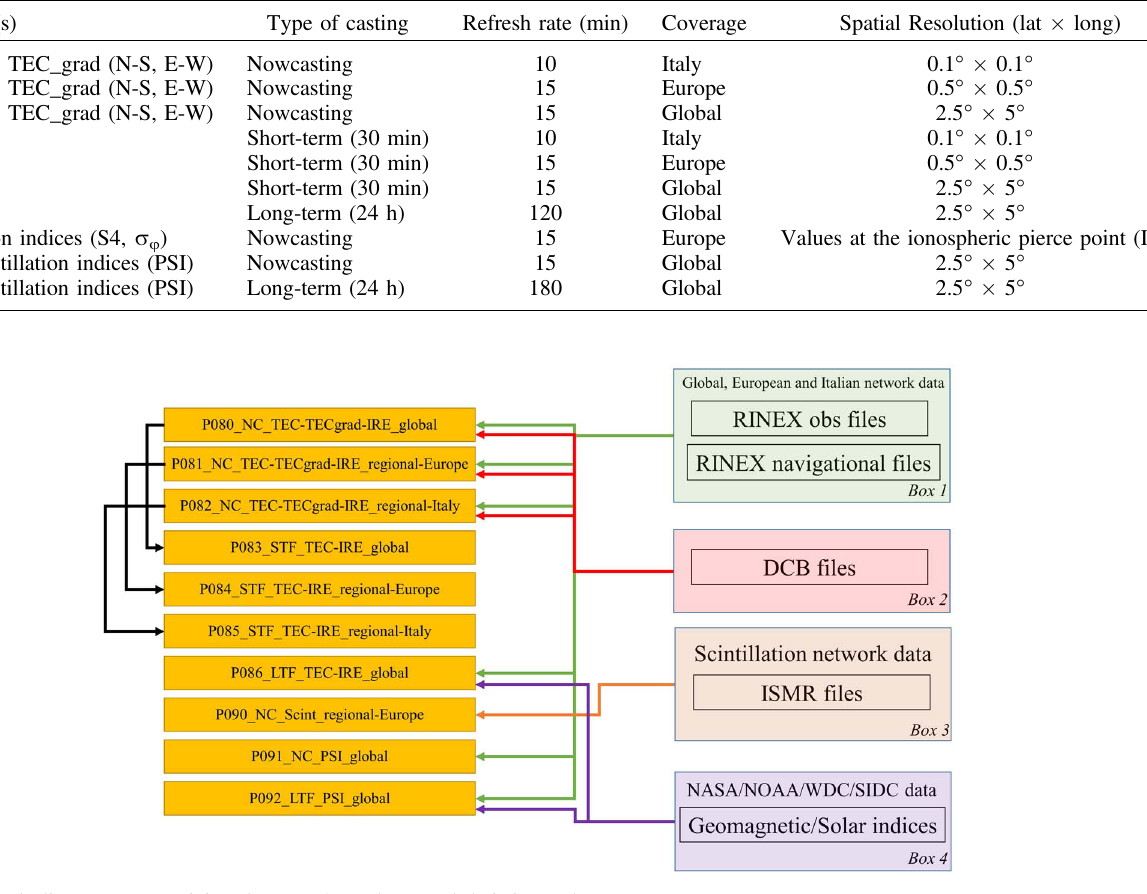
Fig. 2. Block diagram summarizing the RPF 2 products and their input data.